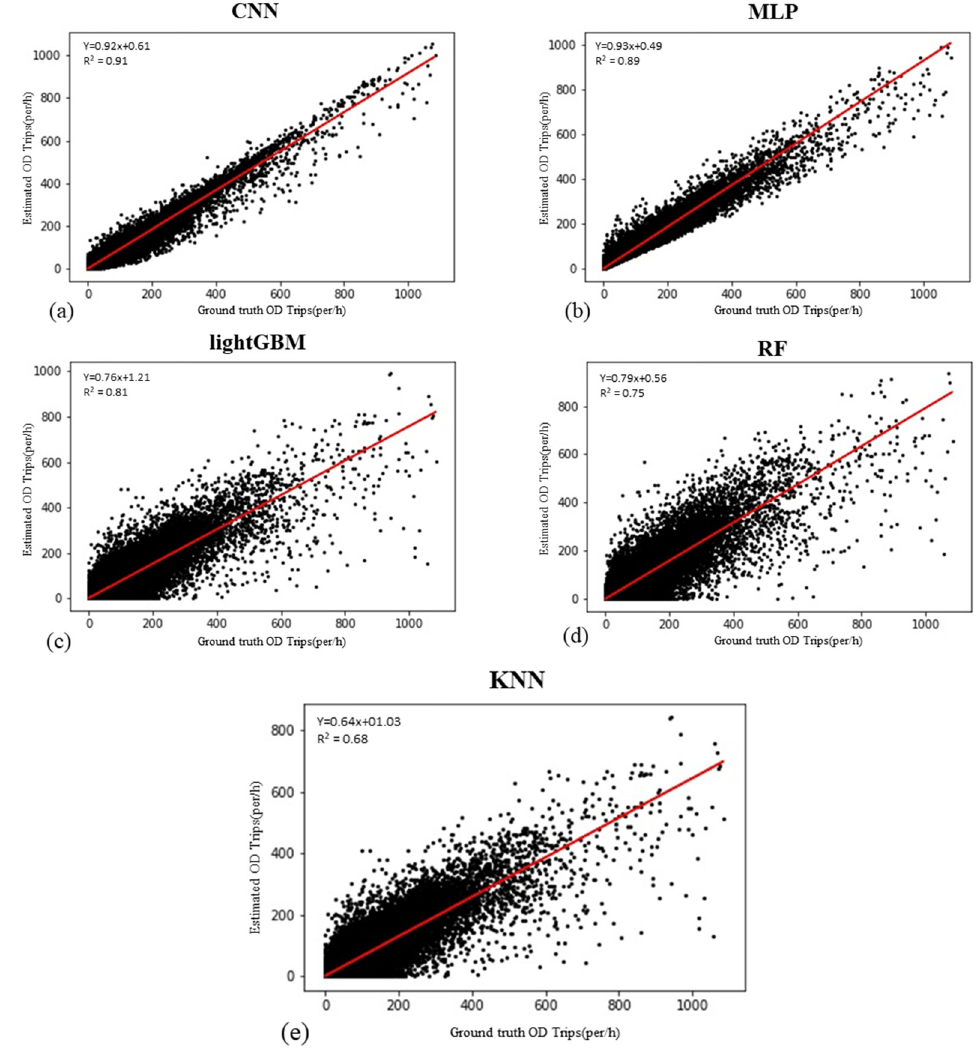
Figure 8. R 2 values of test data for developed models. ( a ) Estimated CNN model vs. Ground truth OD trips, ( b ) Estimated MLP model vs. Ground truth OD trips, ( c ) Estimated LightGBM model vs. Ground truth OD trips, ( d ) Estimated RF model vs. Ground truth OD trips, ( e ) Estimated KNN model vs. Ground truth OD trips.